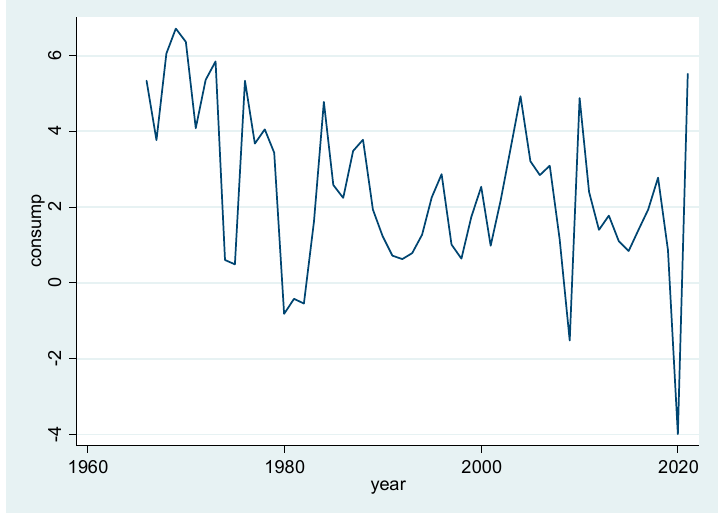
Figure 2. Annual change in primary energy consumption in EU countries. Source: [33].